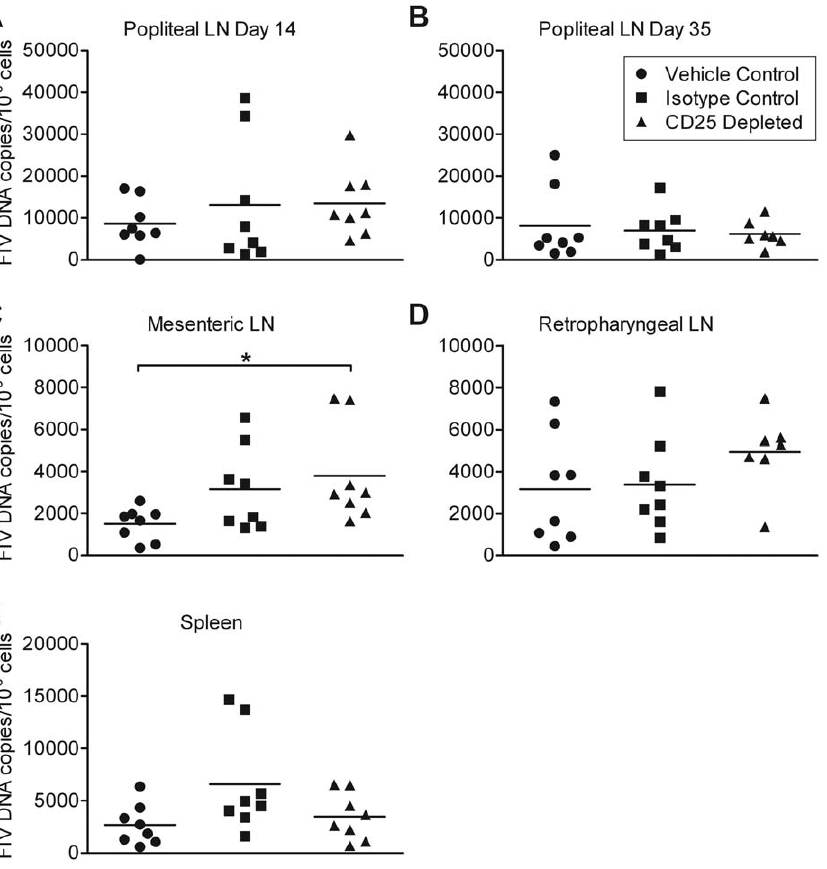
Figure 3. FIV proviral load in tissues is unaffected by anti-CD25 mAb treatment. (A–B) Provirus in popliteal lymph nodes was quantified on days 14 and 35 p.i. (C–E) Provirus in mesenteric and retropharyngeal lymph nodes and spleen was quantified on day 54 p.i. * indicates p , 0.05.